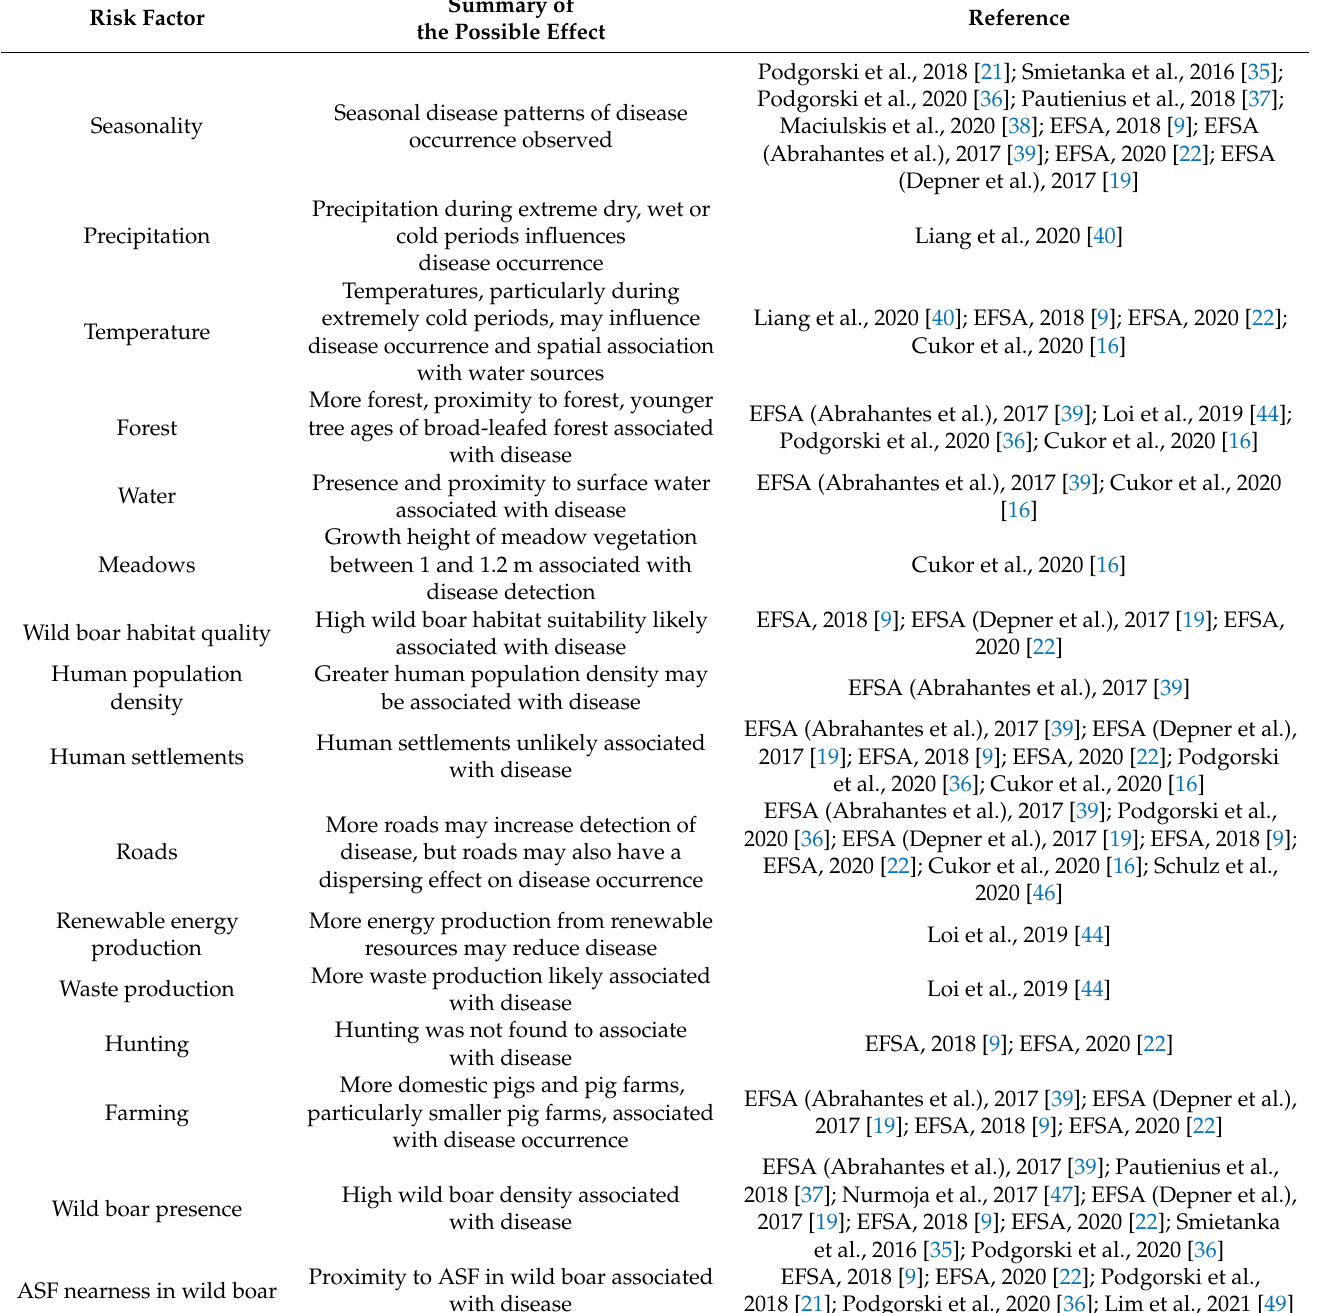
Table 1. Summary of potential environmental risk factors for the occurrence of African swine fever in wild